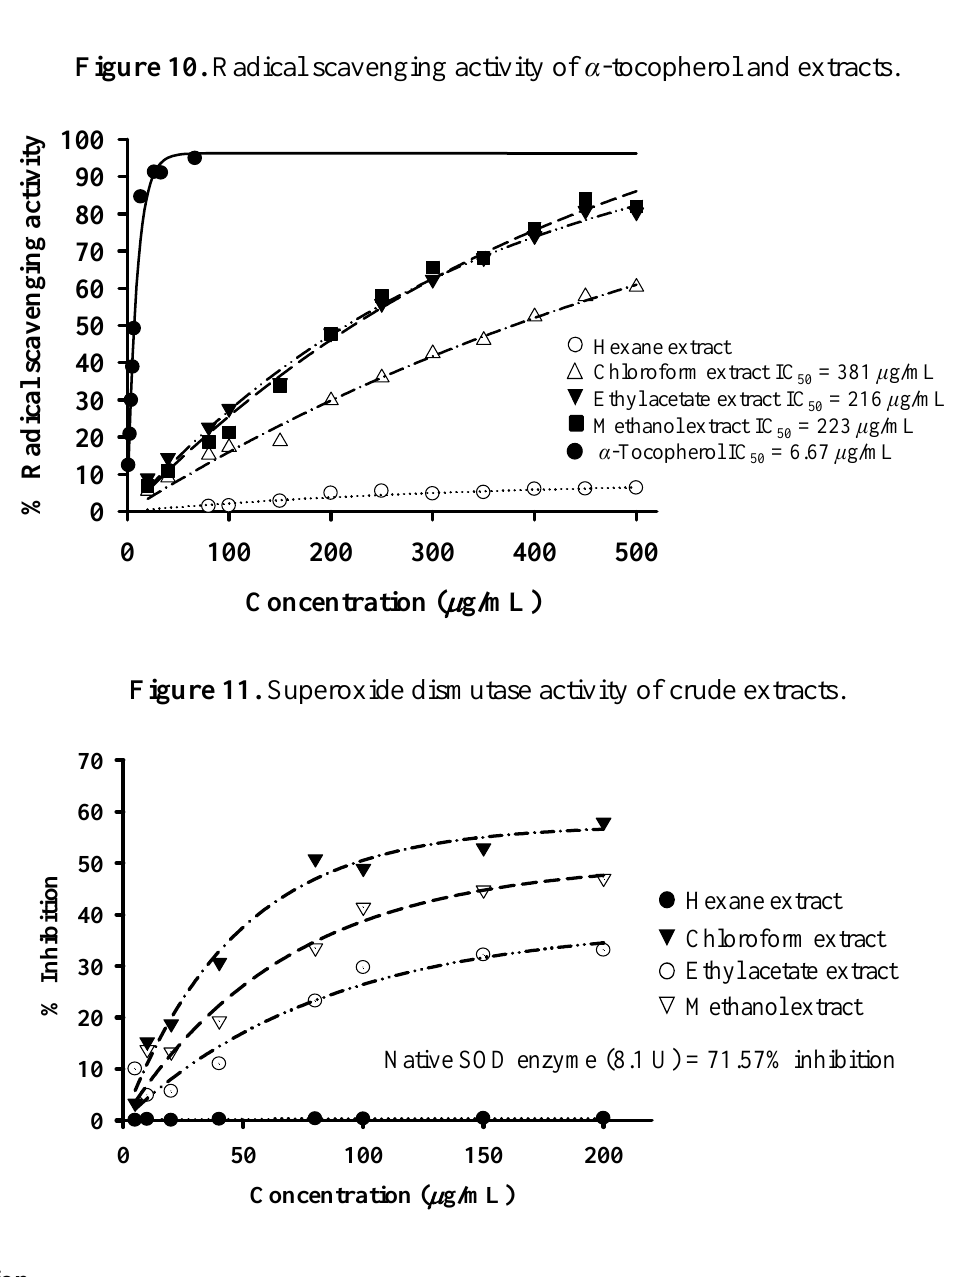
Figure 10. Radical scavenging activity of α -tocopherol and extracts.